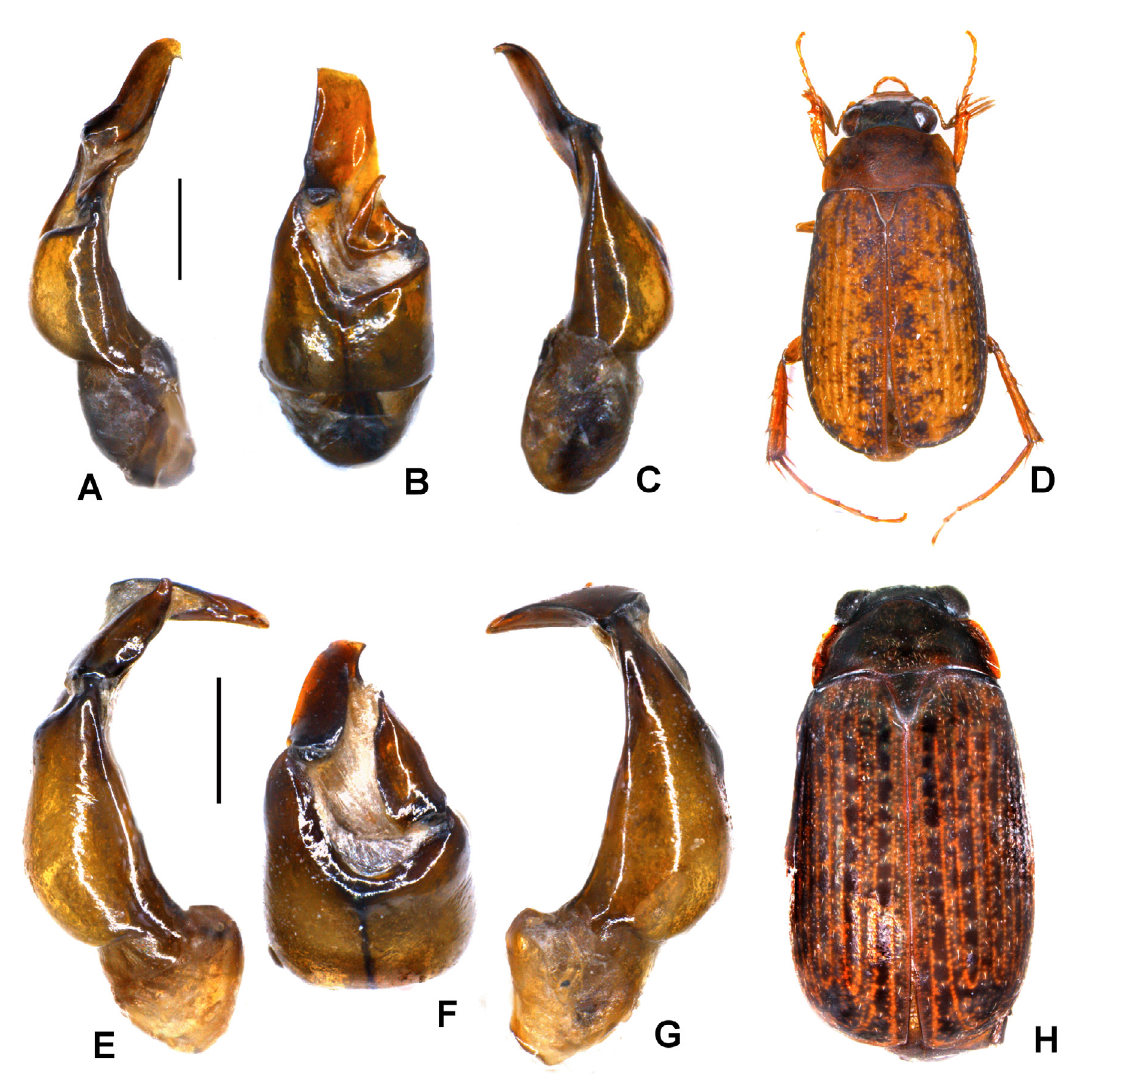
Fig. 4. A–D . Serica (s. str.) eberlei sp. nov., holotype, ♂. E–H . S. (s. str.) tashigaonensis sp. nov., holotype, ♂. A, E . Aedeagus, left side lateral view. C, G . Aedeagus, right side lateral view. B, F . Parameres, dorsal view. D, H . habitus. Scale bars: 0.5 mm. habitus not to